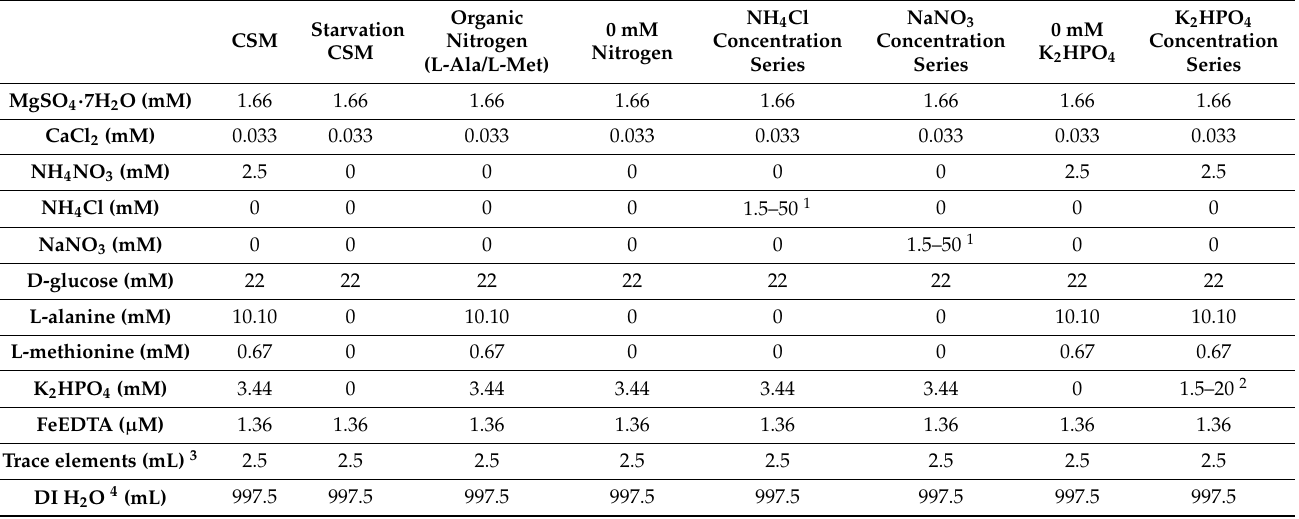
Table 2. Treatment media preparation. CSM is the positive control for all experiments. The treatments 0 mM nitrogen and 0 mM K 2 HPO 4 are the negative controls for each of the nutrient concentration series. Organic NH 4 Cl Starvation 0 mM CSM Nitrogen CSM Nitrogen (L-Ala/L-Met)